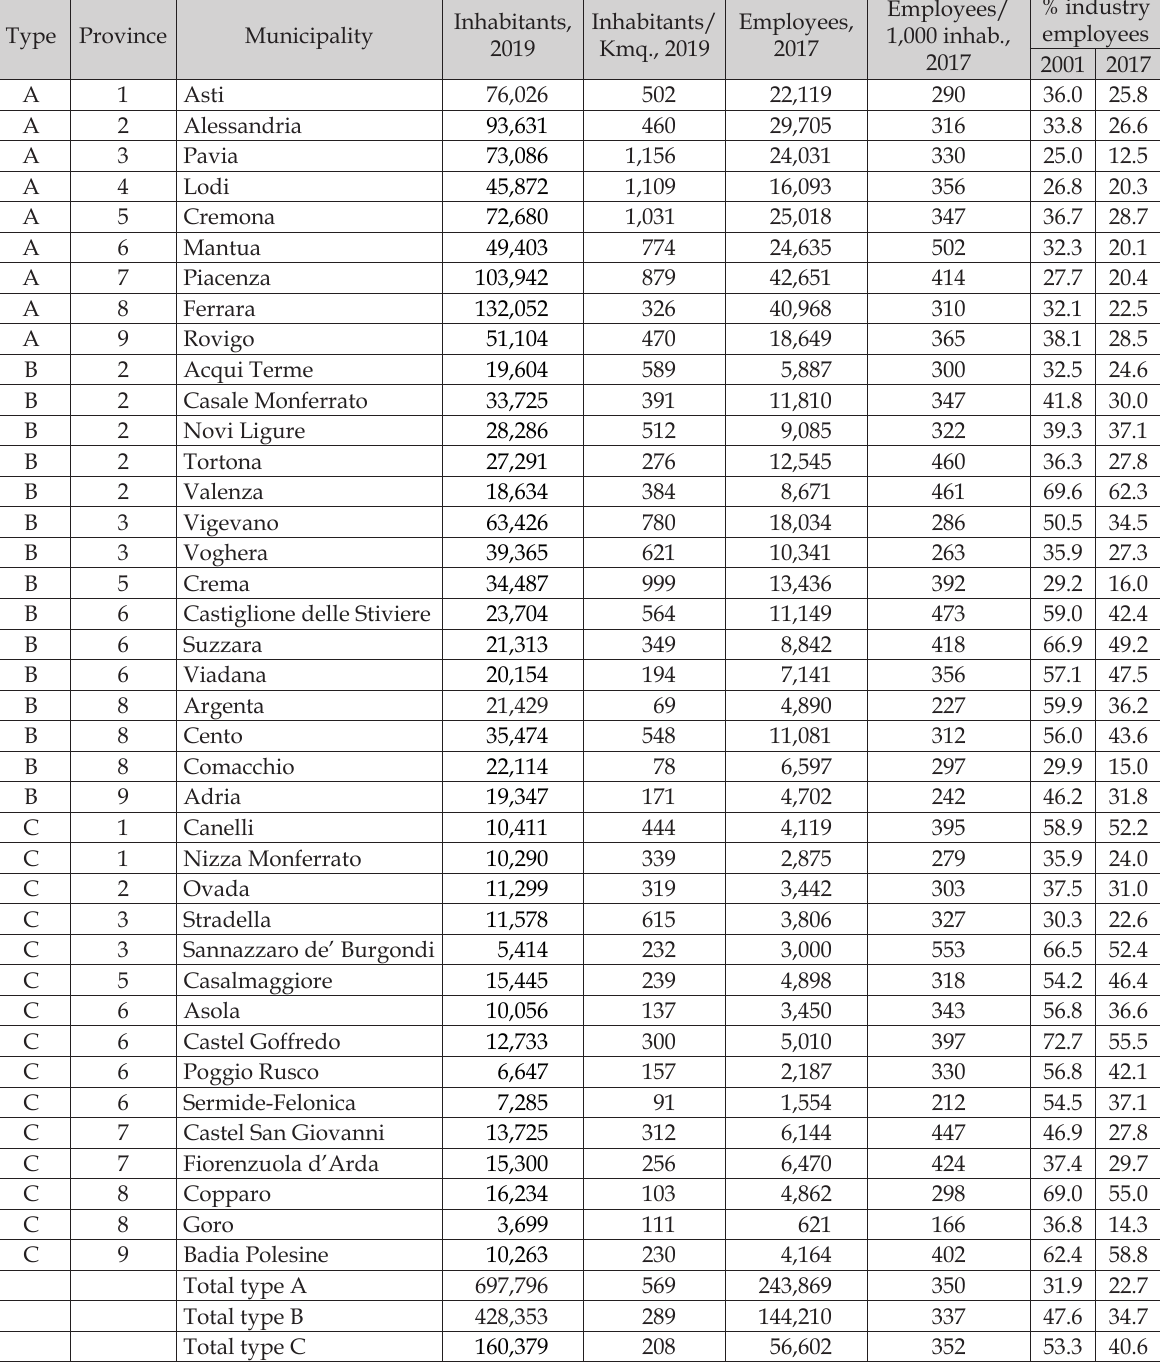
Table 1. The 39 towns analysed: resident population and employees at local units (2001, 2017, 2019). Type